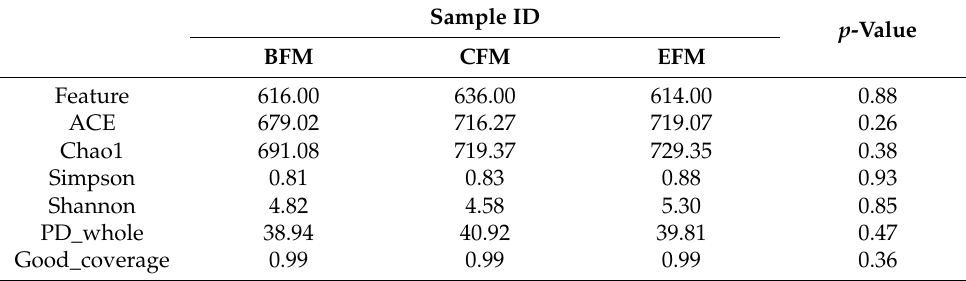
Table 6. Alpha diversity of fecal samples among groups.